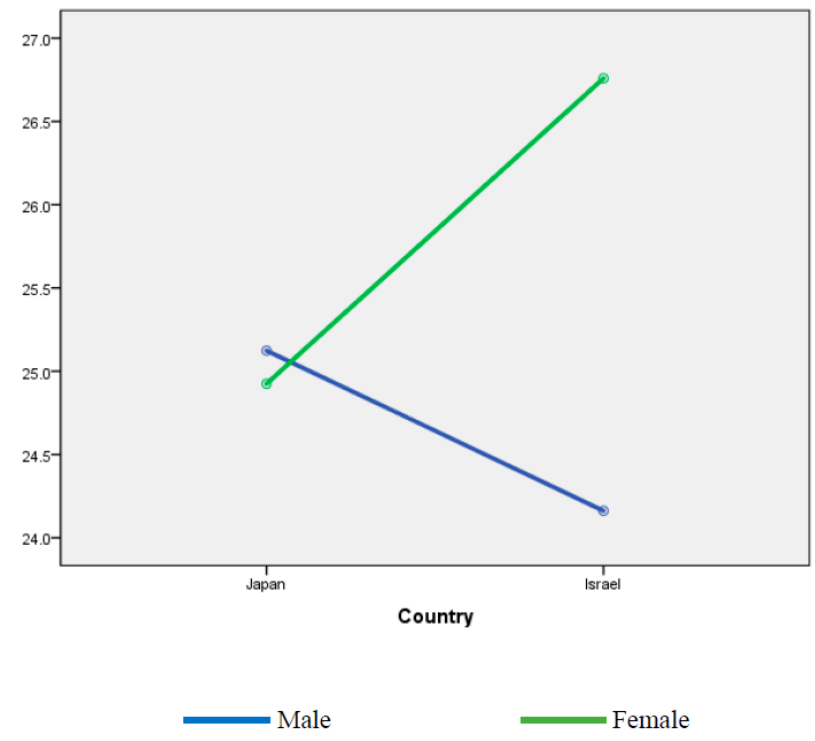
Figure 1. Economic concern by country and gender. The overall economic well-being (EWBS) mean score before COVID-19 was 34.4 (SD = 7.1), being higher among Israeli compared to Japanese students (36.0 (SD = 6.9)